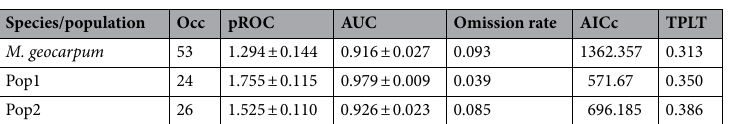
Table 3. Maxent results showing the parameters measuring the three models’ performance and the partial receiver operating characteristic curve (pROC) for each model. Occ number of occurrences, pROC partial receiver operating characteristic curve, AUC area under the receiver operating characteristic curve, AICc corrected Akaike Information Criterion, TPLT 10 percentile Training Plogistic Threshold.